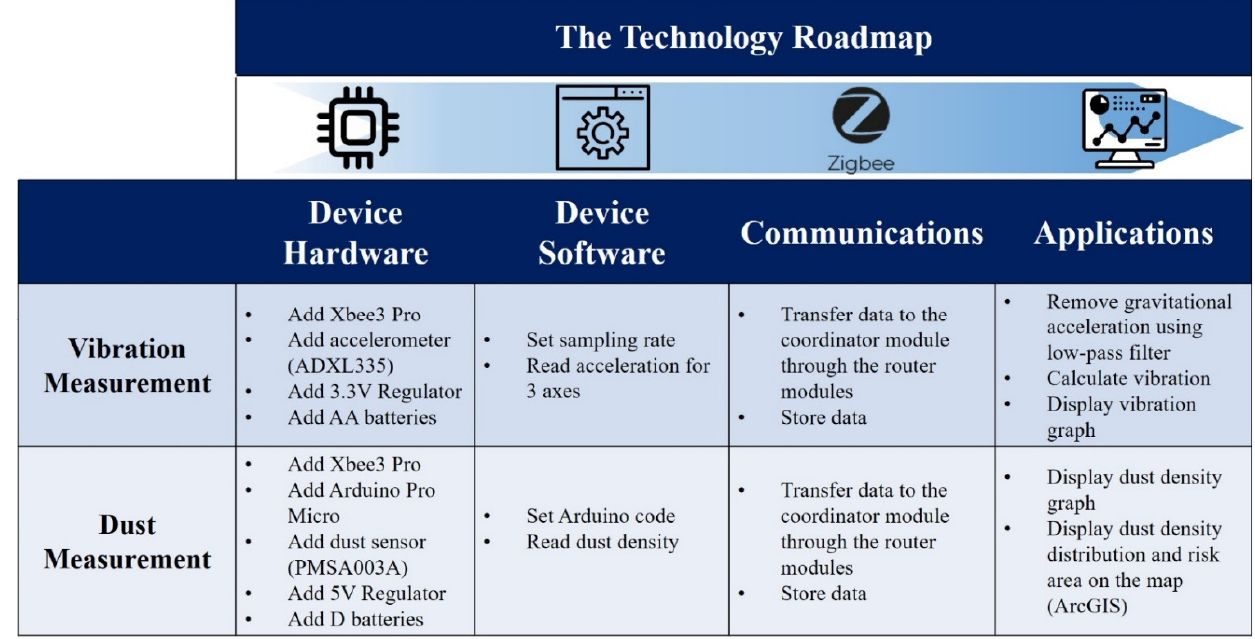
Figure 6. Technology roadmap of vibration and dust measurement modules.